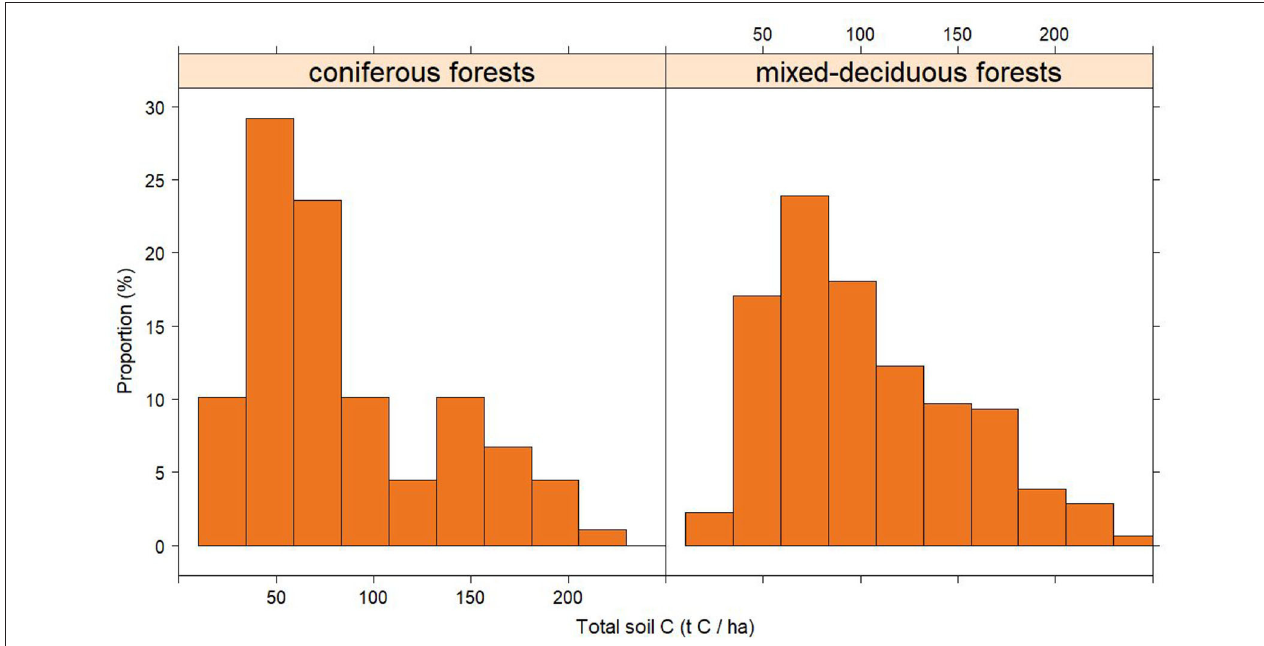
FIGURE 2 | The total soil organic carbon stock (t C/ha) of coniferous and mixed-deciduous forests in Austria based on data of the Austrian Forest Soil